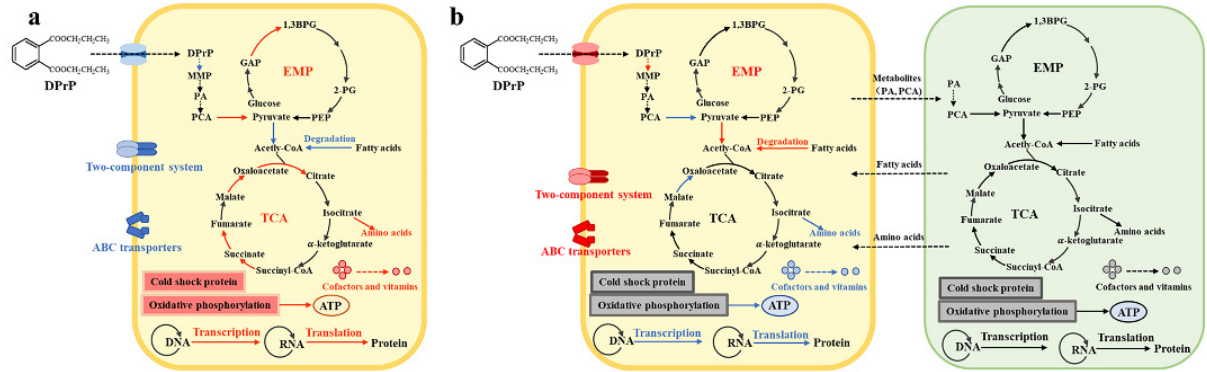
Figure 6. Schematic mechanism of strain ZM05 under Cd(II) stress ( a ) and the interactions between strain ZM05 and strain ZM06 ( b )during DPrP biodegradation. Yellow oblong represents strain ZM05; green oblong represents strain ZM06. The red text represents upregulated metabolism; blue text represents downregulated metabolism.